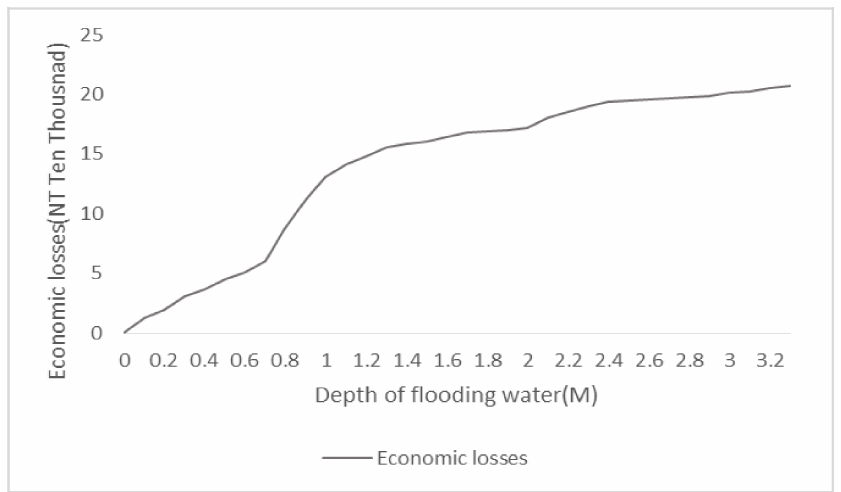
Figure 4. Flood damage estimation for residential area.